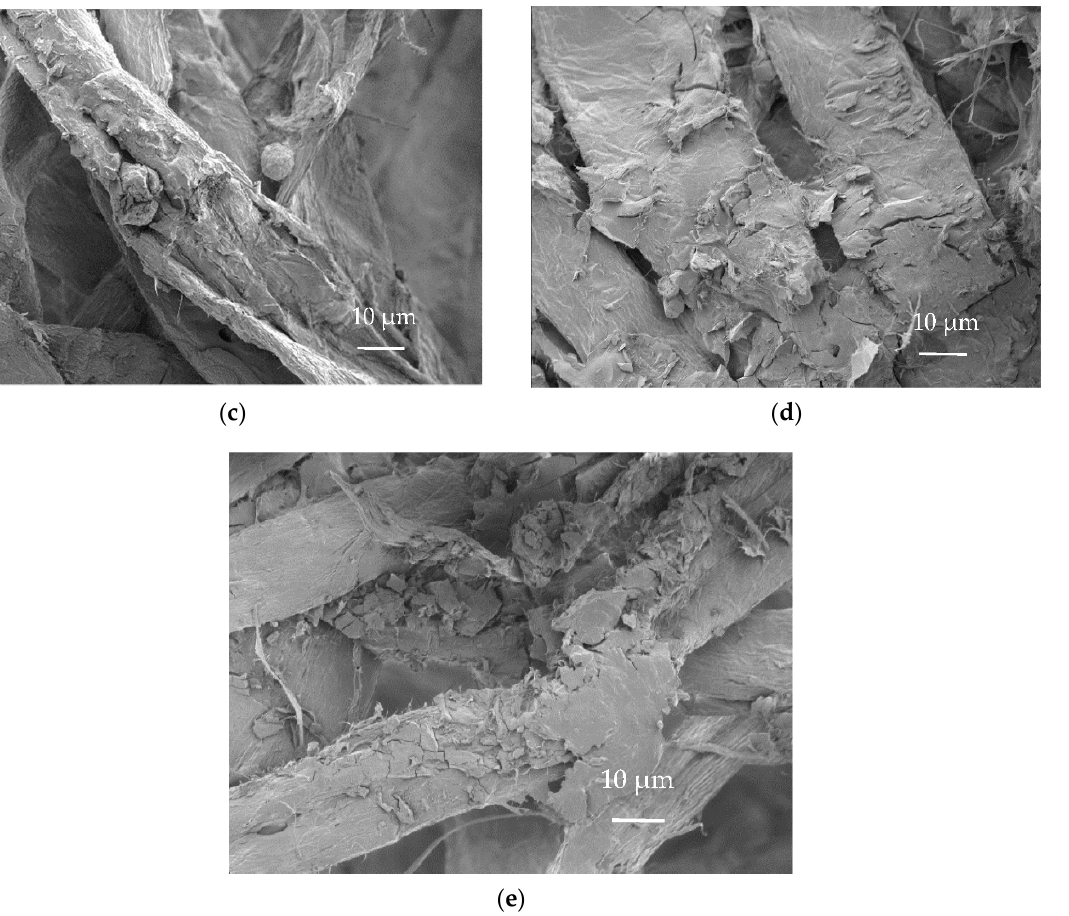
Figure 5. SEM images of pulp fibre pads showing the deposited N-modified lignin and tannin on cellulose fibre surfaces: ( a ) bleached SW kraft pulp (reference), ( b ) +N-modified SW kraft lignin, ( c ) +N-modified SW CatLignin, ( d ) +N-modified HW kraft lignin, and ( e ) +N-modified spruce tannin.